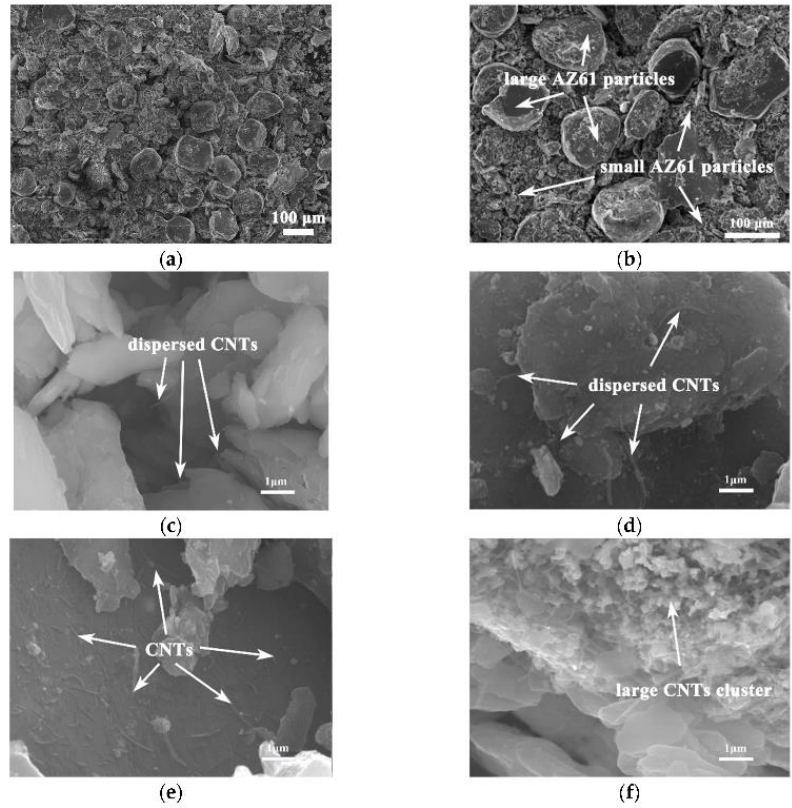
Figure 6. The SEM images of CNTs/AZ61 composites: ( a , b ) low-magnification images, ( c ) 0.5% CNTs, ( d ) 0.75% CNTs, ( e ) 1% CNTs, and ( f ) 1.25% CNTs. Reprinted from Ref. [9]. Copyright 2022 by